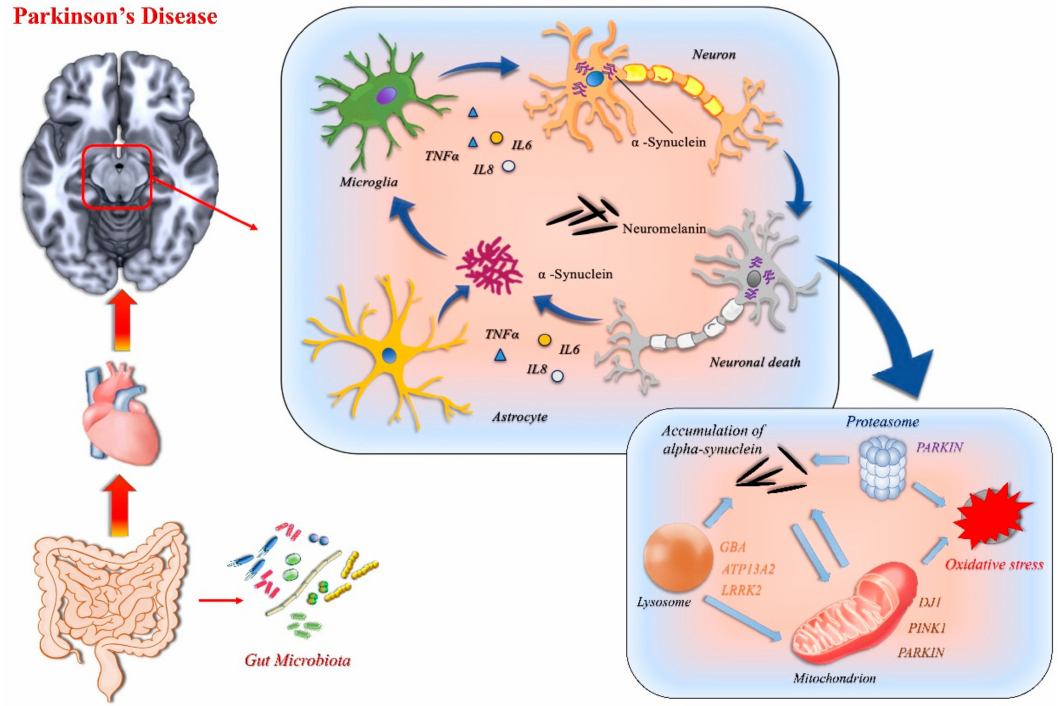
Figure 3. Biochemical and immunological mechanisms associated with the pathogenesis of Parkinson’s